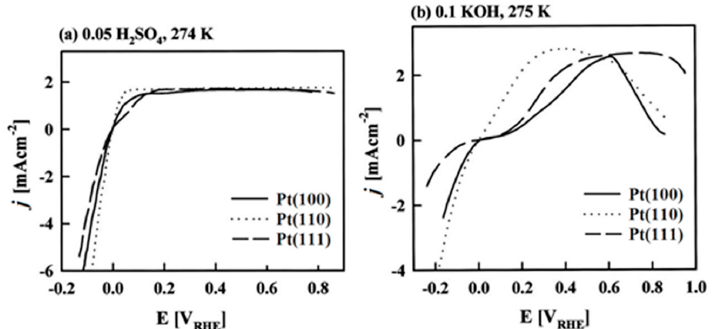
Figure 2. Polarization curves for hydrogen evolution/oxidation on Pt(hkl), with potential sweep rate of 20 mV s − 1 , in ( a ) acid and ( b ) alkaline environments. Adapted from Reference [11], Copyright (2002), with permission from Elsevier.